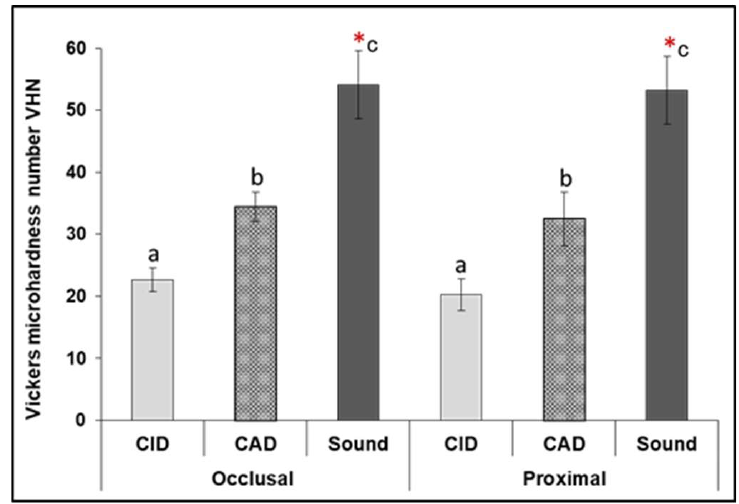
Figure 4. Means of Vickers microhardness number (VHN) of the sound and demineralized dentin (caries-infected and caries-affected) in occlusal and proximal lesions. (*) Statistically significant difference of demineralized dentin from sound ( p < 0.001). Similar litters mean statistically non-significant differences ( p > 0.05) between different dentin zones in occlusal vs. proximal lesions.